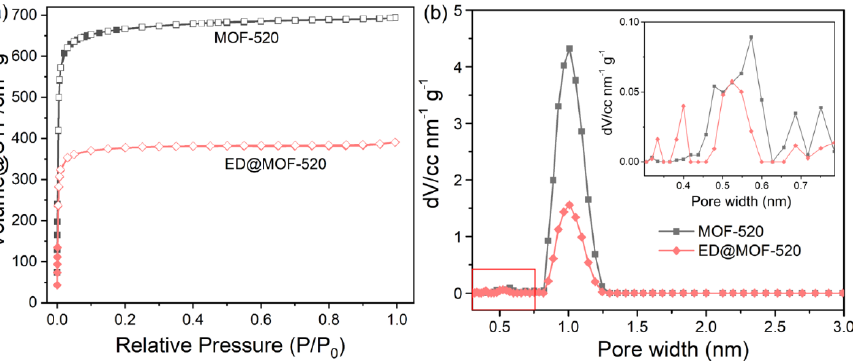
Figure 5. ( a ) N 2 adsorption and desorption isotherms, ( b ) pore size distribution curves (Inset: pore distribution curves in the interval of 0 to 0.8 nm).